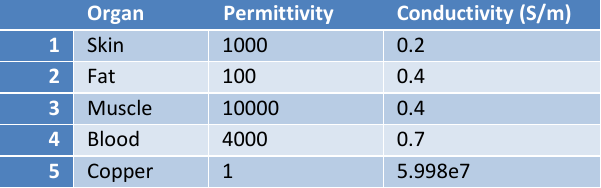
Table 1: The dielectric properties of organs at 100 kHz [10,12,13].